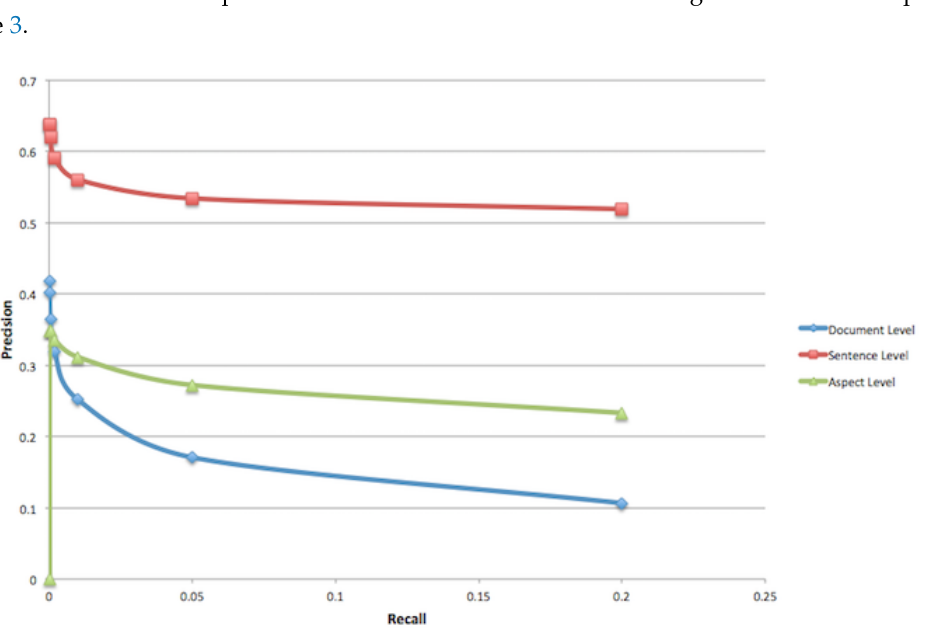
Figure 3. Precision–recall curves of our proposed GAN model on the 20 Newsgroups, the Movie Reviews, and the Finegrained